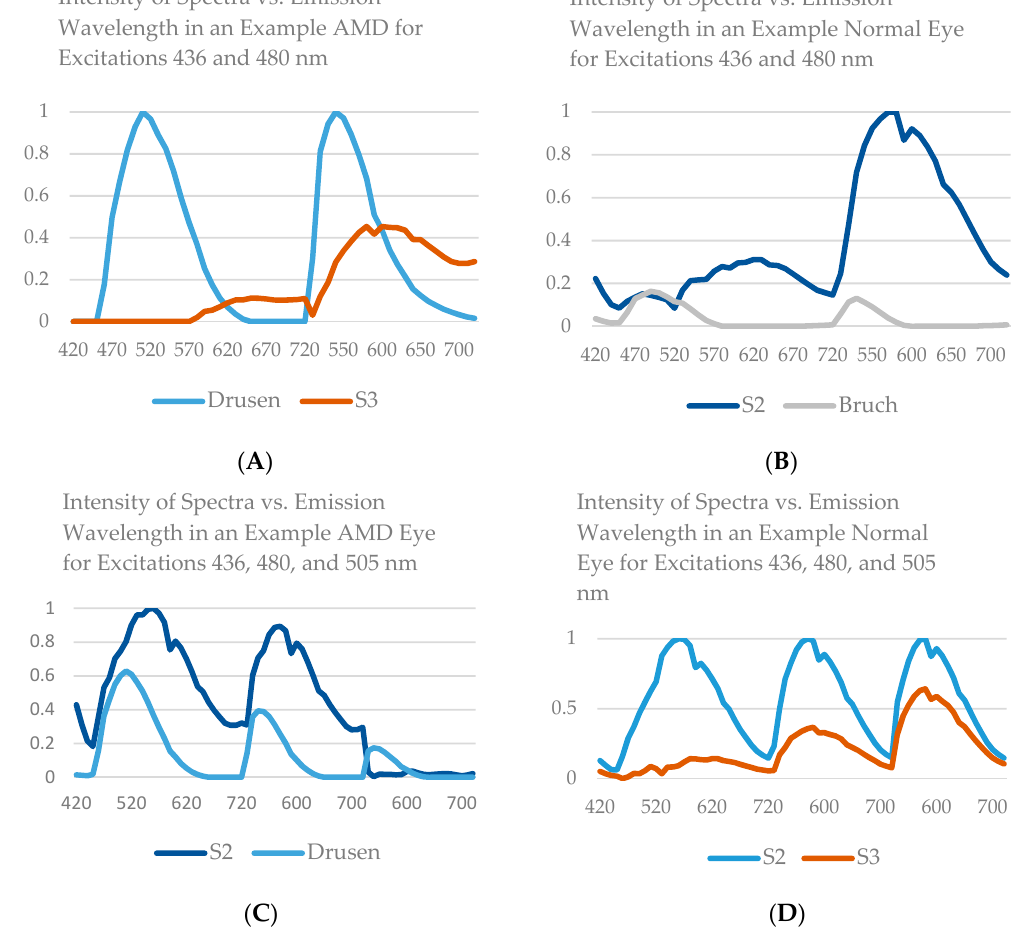
Figure 4. Spectral recovery of selected fluorophores from two and three wavelength excitations, and AMD and control samples corresponding to abundances in Figures 1 and 2. The spectra are normalized to one. ( A ) Two wavelength excitation spectra for a normal eye corresponding to S2 (Figure 3A) and Bruch (Figure 3C). ( B ) Two wavelength excitation spectra for an AMD eye corresponding to S3 (Figure 2A) and SDr (Figure 2C). ( C ) Three wavelength excitation spectra for a normal eye corresponding to S2 (Figure 3B) and S3 (Figure 3D). ( D ) Three wavelength excitation spectra for an AMD eye corresponding to S2 (Figure 2B) and SDr (Figure 2D).